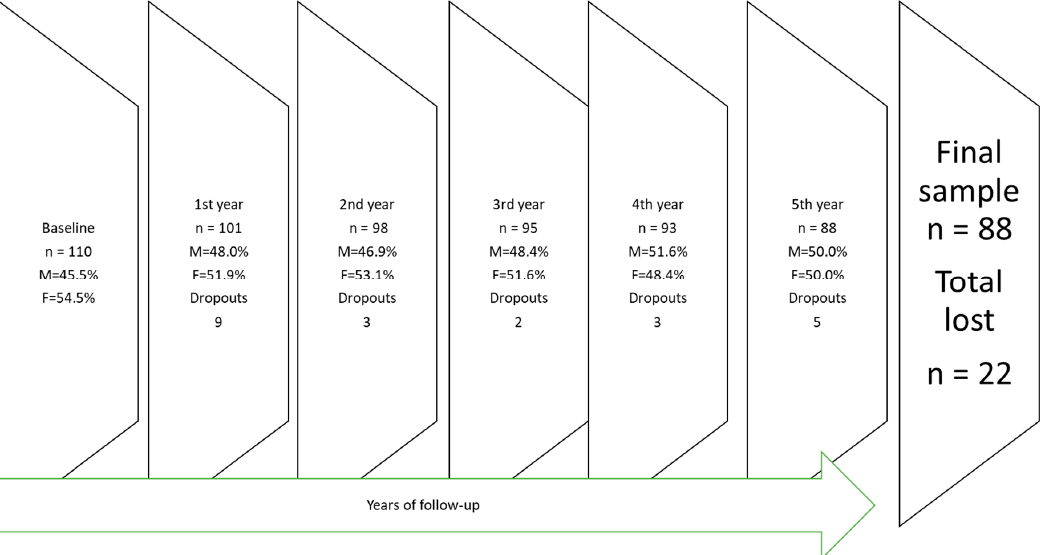
Figure 1. Number of children lost during follow-up during each year of the study. Int. J. Environ. Res. Public Health 2019 , 16 , x